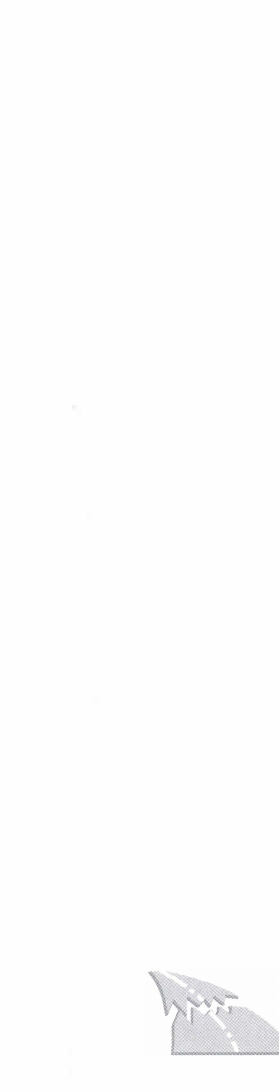
Allen bisher vorgestellten Spezifikationen liegt die Annahme zugrunde, daB ent­ sprechend der Hochtemperatureigenschaften ausge­ wahlter Bitumen sich fur niedrige Temperaturen, Fig. 2: Rheological Characteristics of a Typical Unmodified Bitumen During its Life Cycle